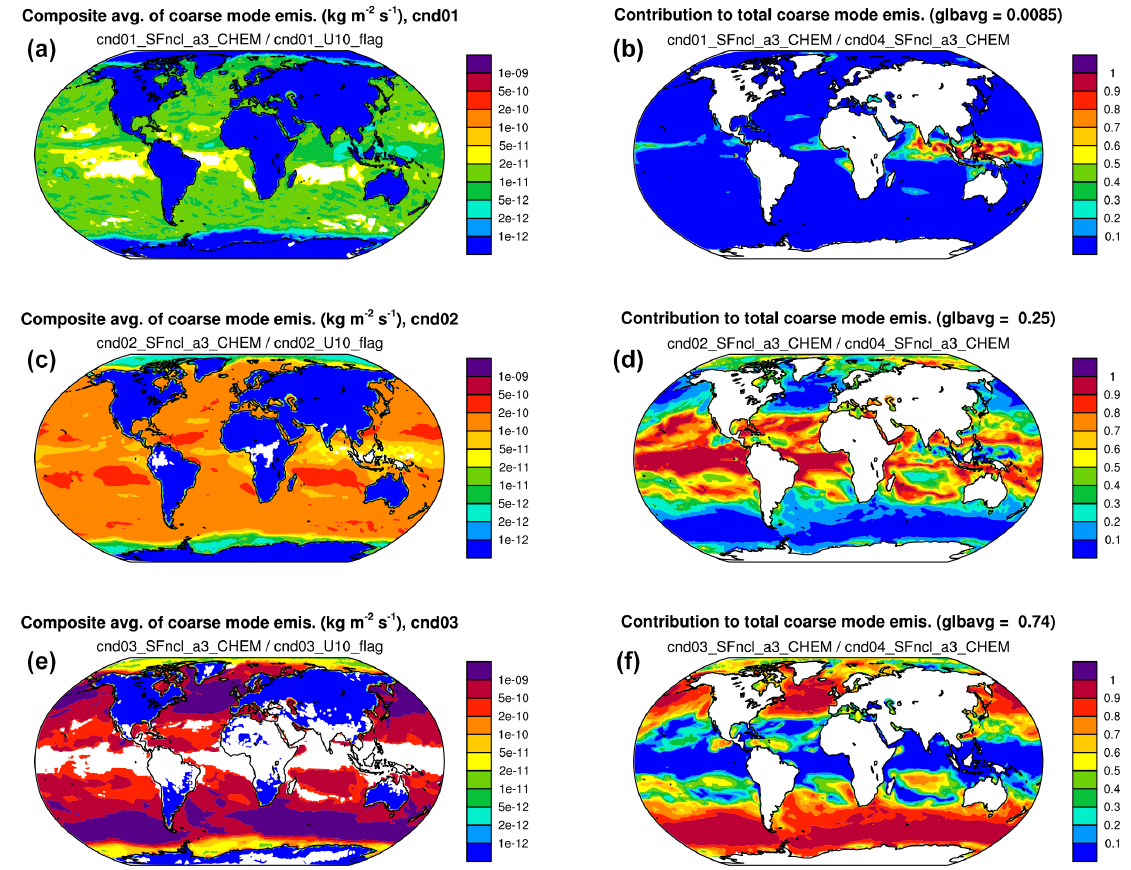
Figure 8. (a, c, e) Composite average of coarse-mode sea salt mass emission fluxes under conditions 1–3 corresponding to 10m wind speed < 5ms − 1 (a, b) , between 5 and 10ms − 1 (c, d) , and > 10ms − 1 (e, f) . (b, d, f) Contribution of each condition (1, 2, or 3) to the total coarse-mode sea salt emission (condition 4). White areas in the left panels are missing values caused by zero frequency of occurrence of the corresponding conditions. White areas in the right panels are missing values caused by zero total coarse-mode sea salt emission. The expressions given below panel titles indicate how the presented quantities are calculated from the model’s output